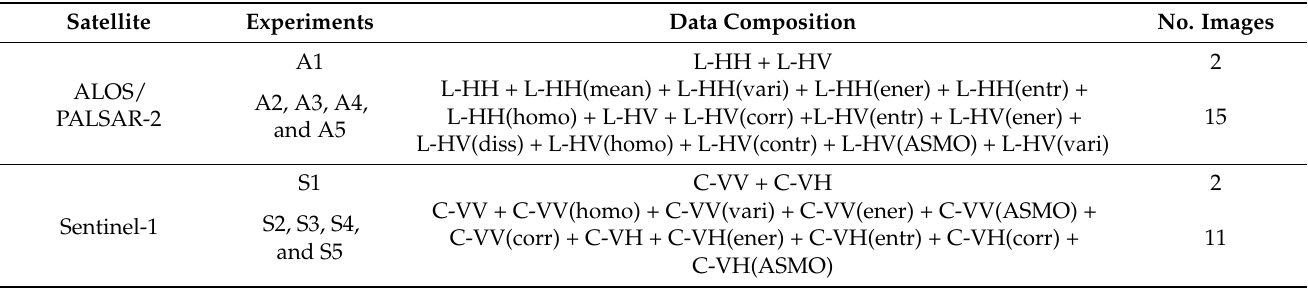
Table 2. Organization of texture features used in each experiment, after PCA